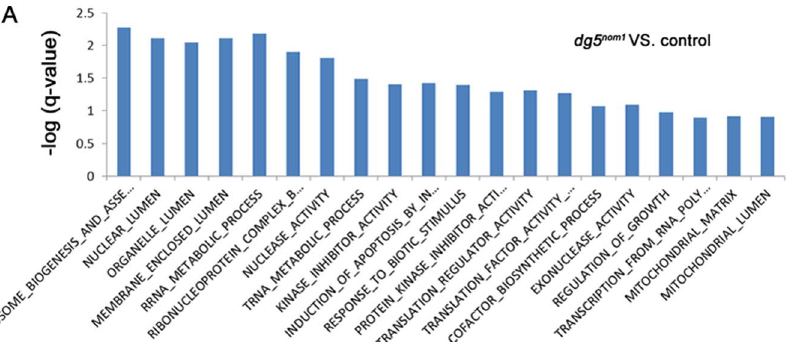
Figure 5. Enrichment analysis of differentially expressed genes in dg5 nom1 mutant. The mostly enriched GO categories for genes upregulated in dg5 nom1 embryos as compared to control embryos. GO categories are ranked by their q -value.